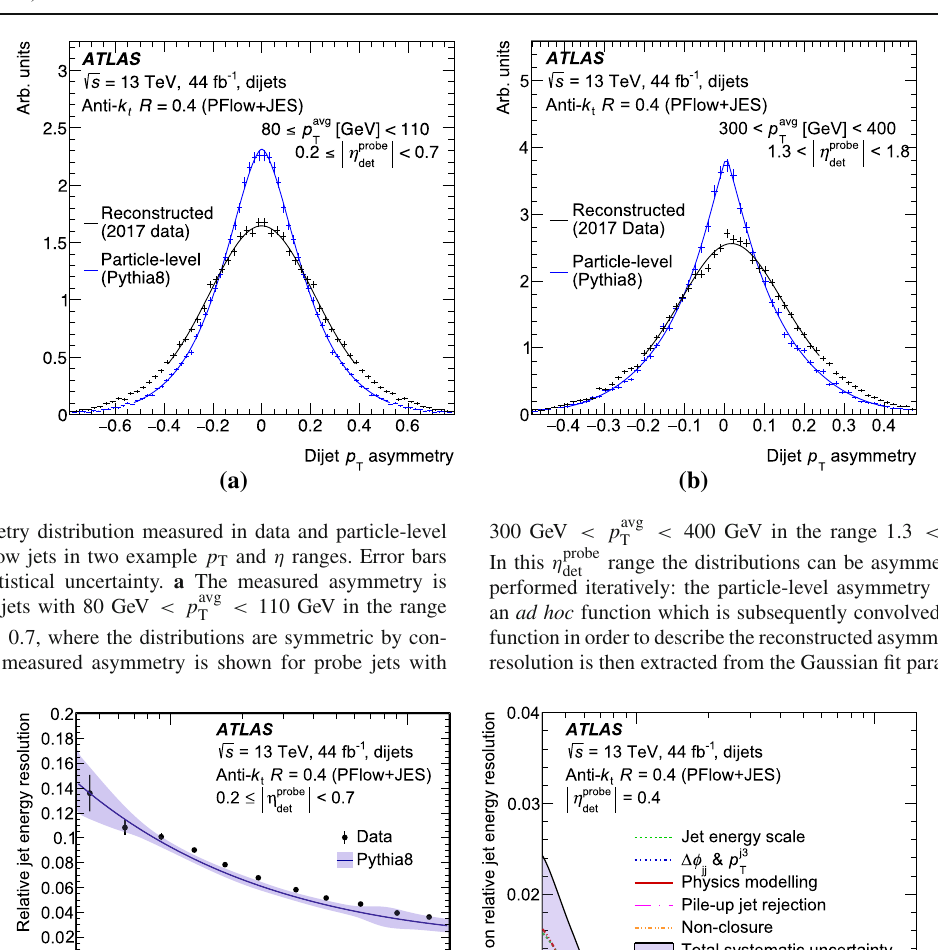
the blue band. The systematic uncertainty is dominated by terms prop- agated from the JES uncertainty, while additional terms arise from the analysis selection, pile-up rejection (JVT), physics modelling (compar- ison with alternative generator), and non-closure effects. The bump